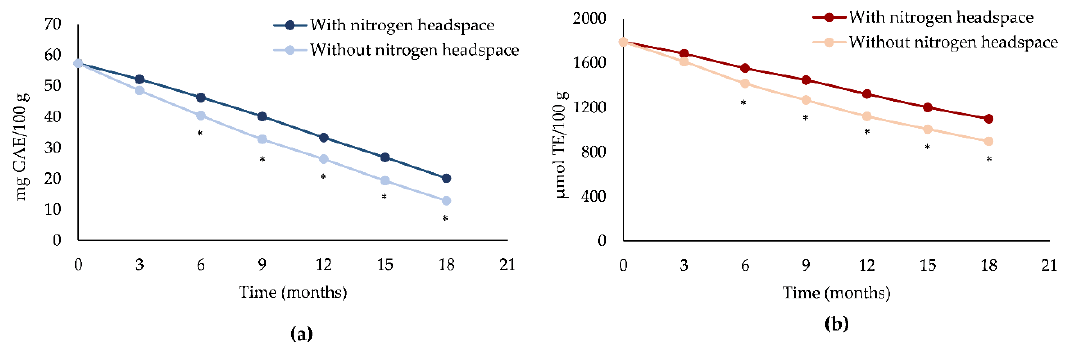
Figure 2. Antioxidant and free-radical scavenging activity decay of EVOOs with or without a nitrogen headspace measured by Folin-Ciocalteu ( a ) and ORAC assay ( b ) during storage time (T 0 –T 18 months). * p < 0.001 vs EVOO with a nitrogen headspace.